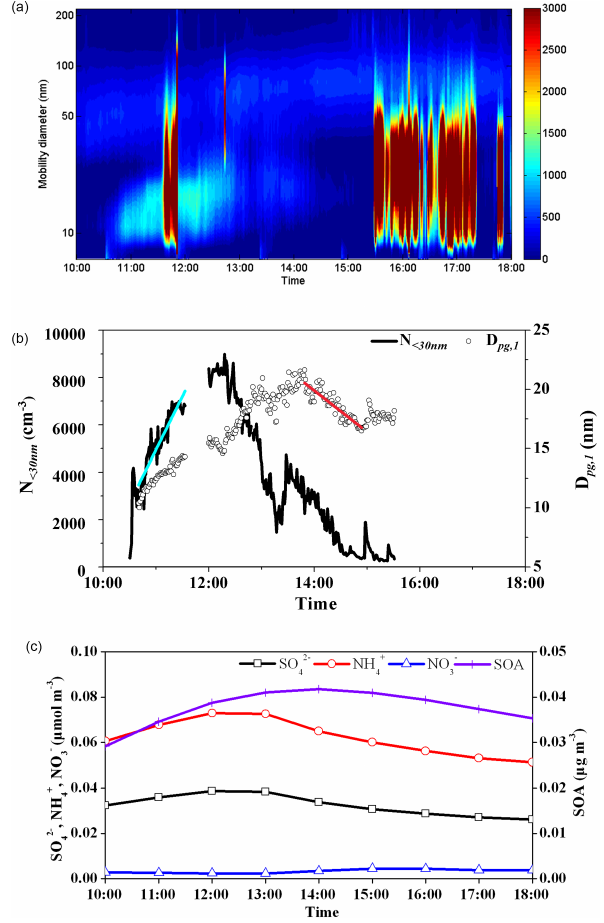
Figure 6. New particle formation on 26 October 2011 a particle number concentrations from FMPS (cm − 3 ), (b) variations of me- dian diameter of particle mode ( D pg , 1 ) and number concentrations of nucleation mode particles ( N < 30nm ), (c) CMAQ simulation of SO 2 − , NH + , NO − and SOA in PM 2 . 5 4 4 3